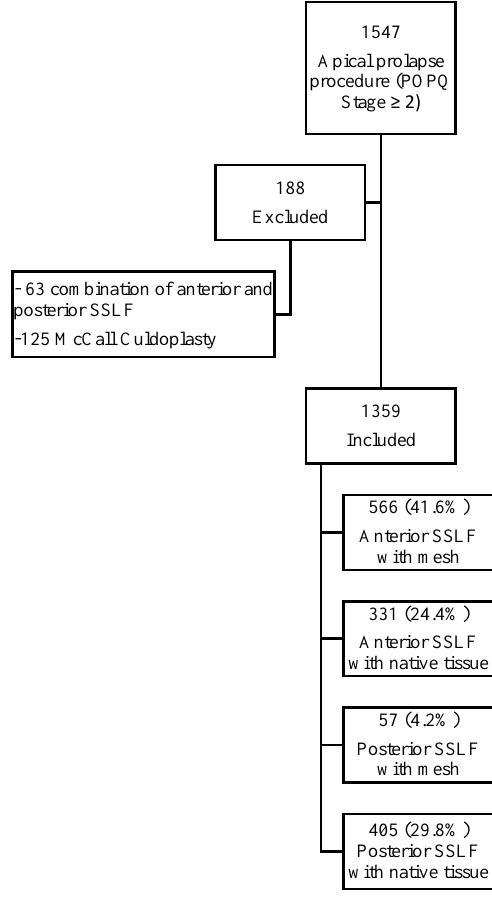
Figure 1. Study flowchart. Table 1. Baseline characteristics for the total population and between the four surgical